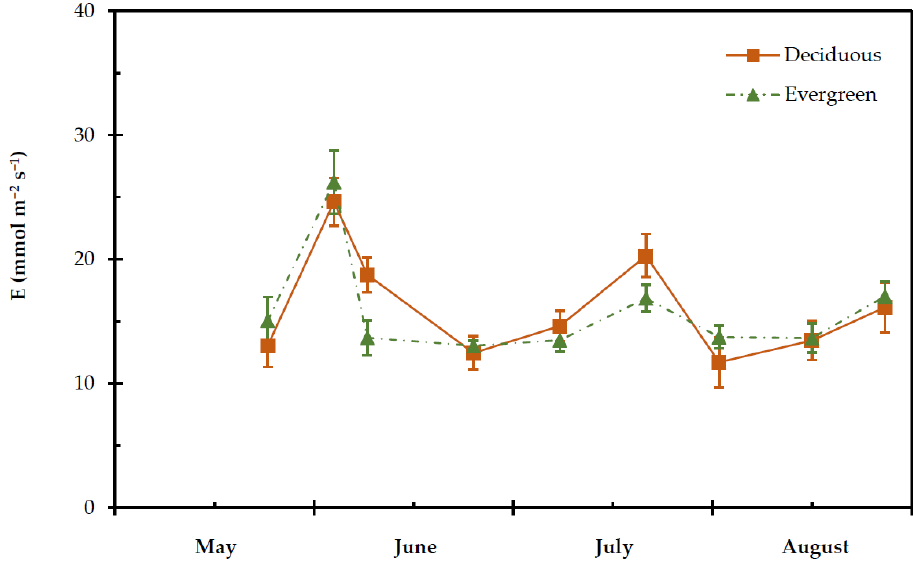
Figure 5. Seasonal transpiration rate (Ε) of deciduous and evergreen shrubs during the experimental period, from 27 May to 28 August. The values are means ± SE ( n = 24).